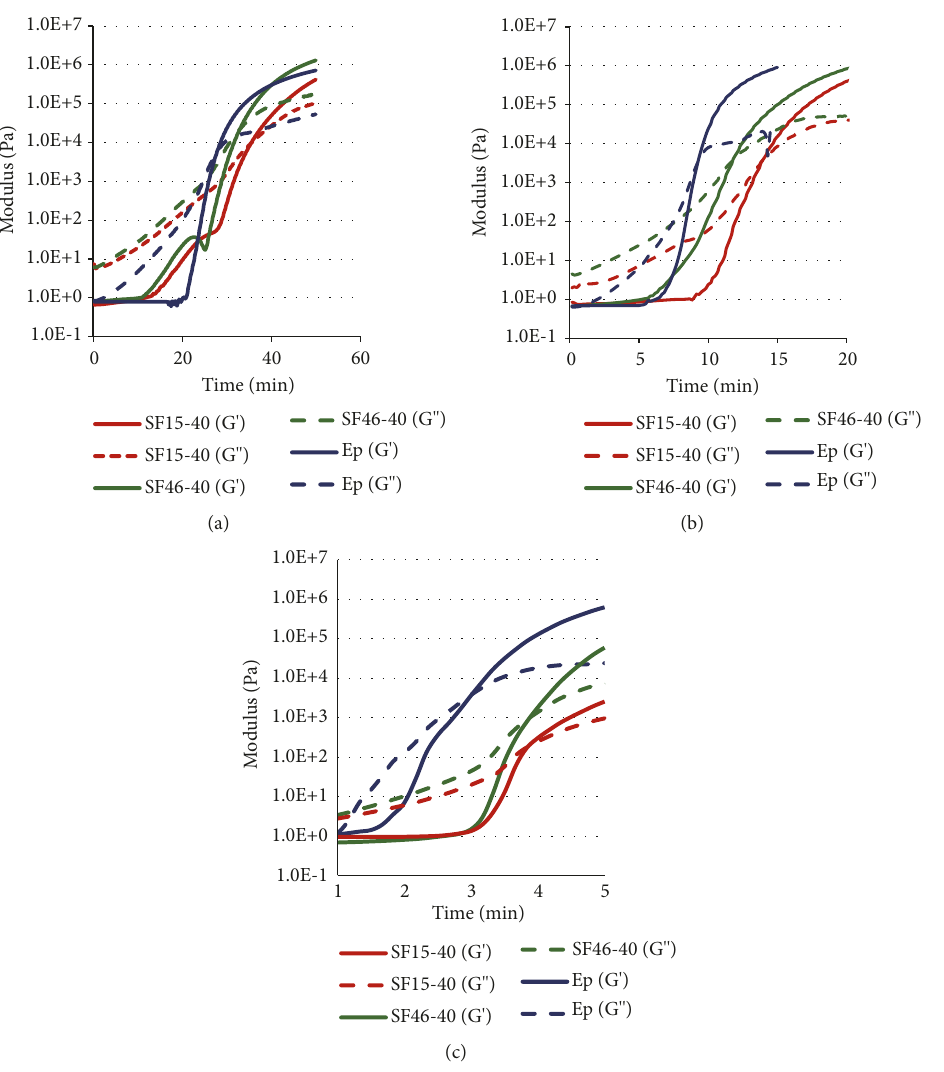
Figure 4: Isothermal gelation profiles of resin and syntactic foam formulations at different temperatures: (a) 60 ∘ C, (b) 80 ∘ C, and (c) 100 ∘ C (dotted lines G”, solid lines G’).